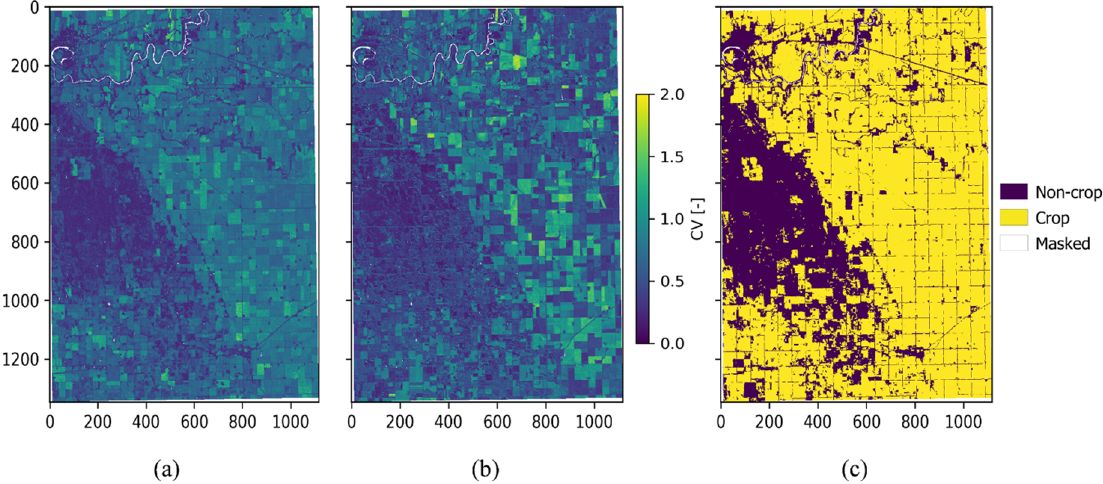
Figure 2. Coefficient of variation (CV) values for ( a ) Sentinel-1 and ( b ) PALSAR-2 data. ( c ) The Annual Cropland Inventory (ACI) after it had been classified as crop and non-crop. Water is masked (white). Pixels are 29 m × 31 m. The x- and y-values are the coordinates of the pixels in the raster, with 0,0 being the top left corner.